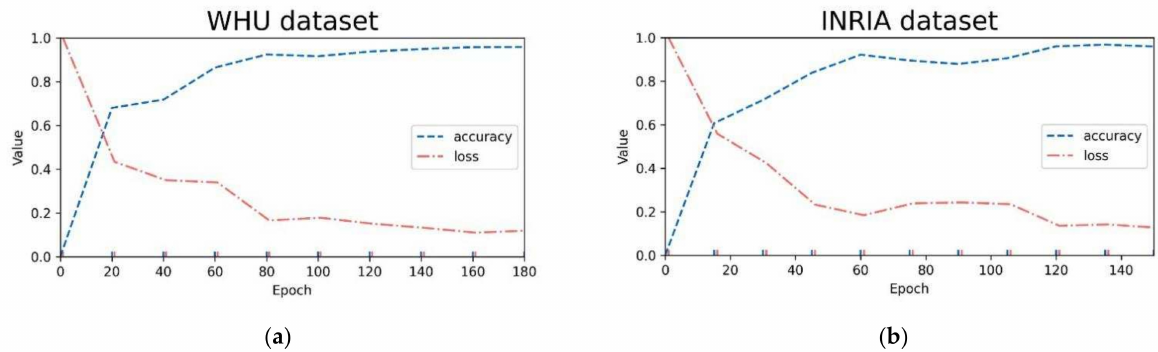
Figure 5. Variation in training accuracy and loss value of AGs-Unet in: ( a ) WHU dataset; and ( b ) INRIA